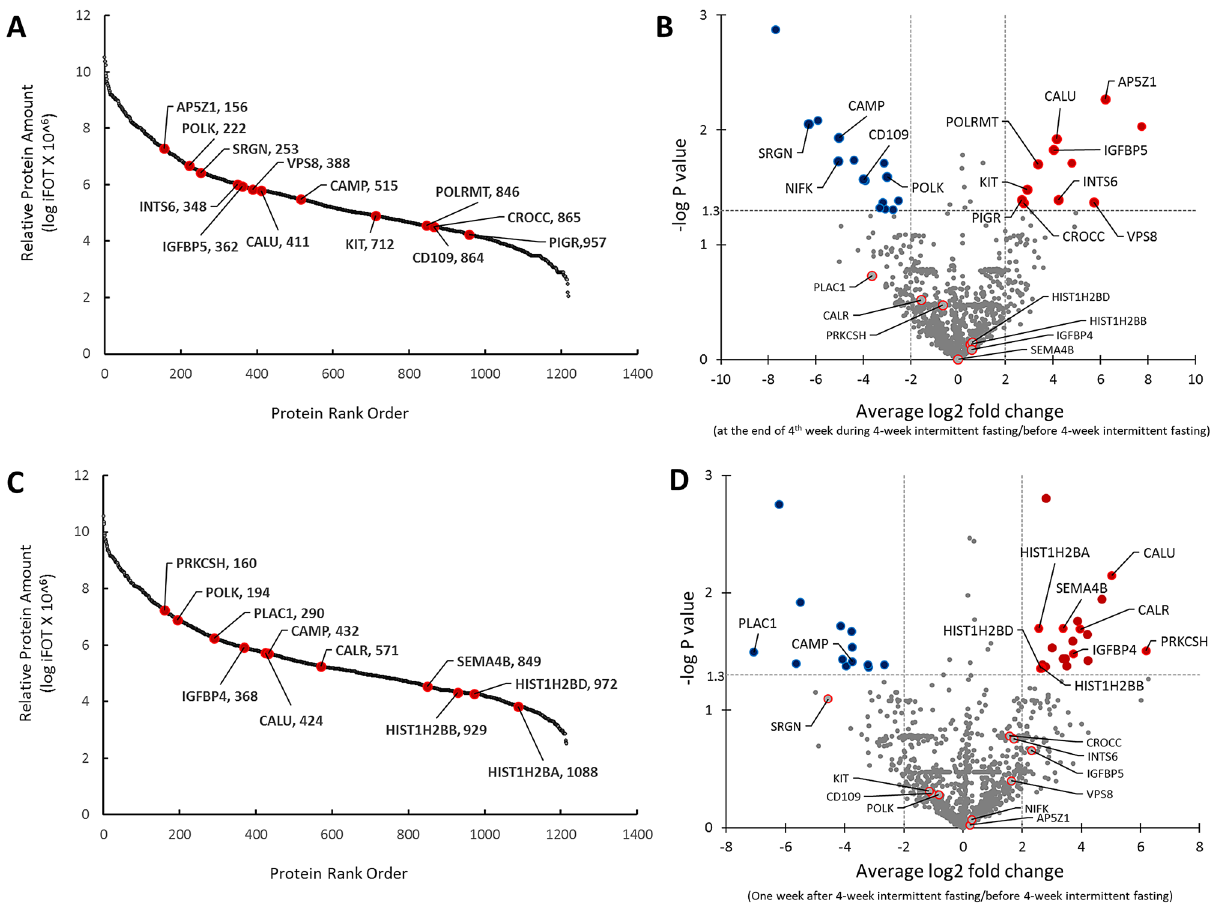
Figure 2. Gene protein products (GP) recovered at the end of 4th week during 4-week intermittent fasting and one week after 4-week intermittent fasting. ( A ) Distribution of normalized relative GP amount and location of focused significantly increased or decreased proteins in serum samples taken at the end of 4th week during 4-week intermittent fasting shown in GP name and rank order. ( B ) Volcano plot shows selected GPs that had an equal to or greater than fourfold significant change (blue and red colors represent a significant decrease and increase in the levels of GPs, respectively) at the end of 4th week during 4-week intermittent fasting compared with the levels before 4-week intermittent fasting. ( C ) Distribution of normalized relative GP amount and location of focused significantly increased or decreased proteins in serum samples taken 1 week after 4-week intermittent fasting shown in GP name and rank order. ( D ) Volcano plot shows selected GPs that had an equal to or greater than fourfold significant change (blue and red colors represent a significant decrease and increase in the levels of GPs, respectively) 1 week after 4-week intermittent fasting compared with the levels before 4-week intermittent